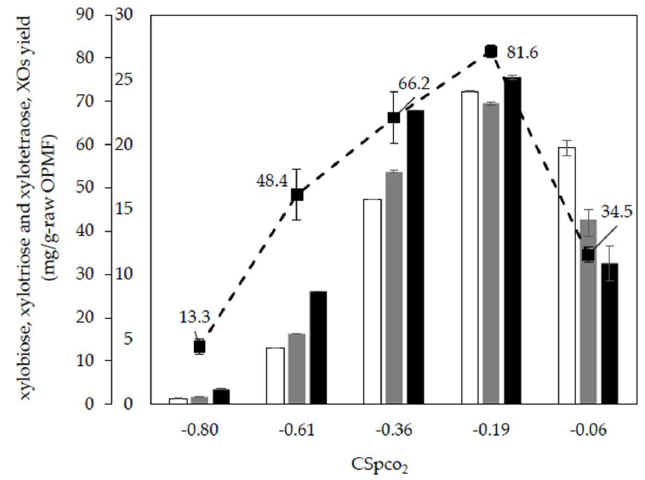
Figure 1. XOs characterization (with respective error bar) for ( ) xylobiose, ( ) xylotriose, ( ) xylotetraose, (- - -) XOs yield. xylotetraose, (- - -) XOs xylotetraose, (- - -) XOs yield. xylotetraose, (- - -) XOs yield. xylotetraose, (- - -) XOs yield.